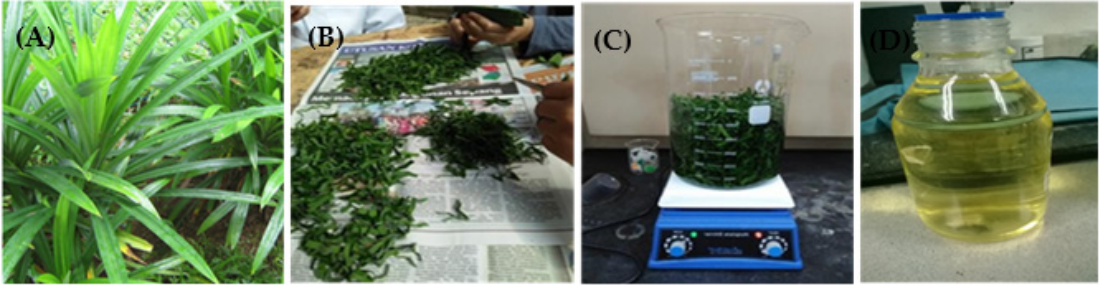
Figure 1. ( A ) Pandanus amaryllifolius leaves, ( B ) cutting process, ( C ) boiling process, ( D ) Pandanus amaryllifolius leaves extract.